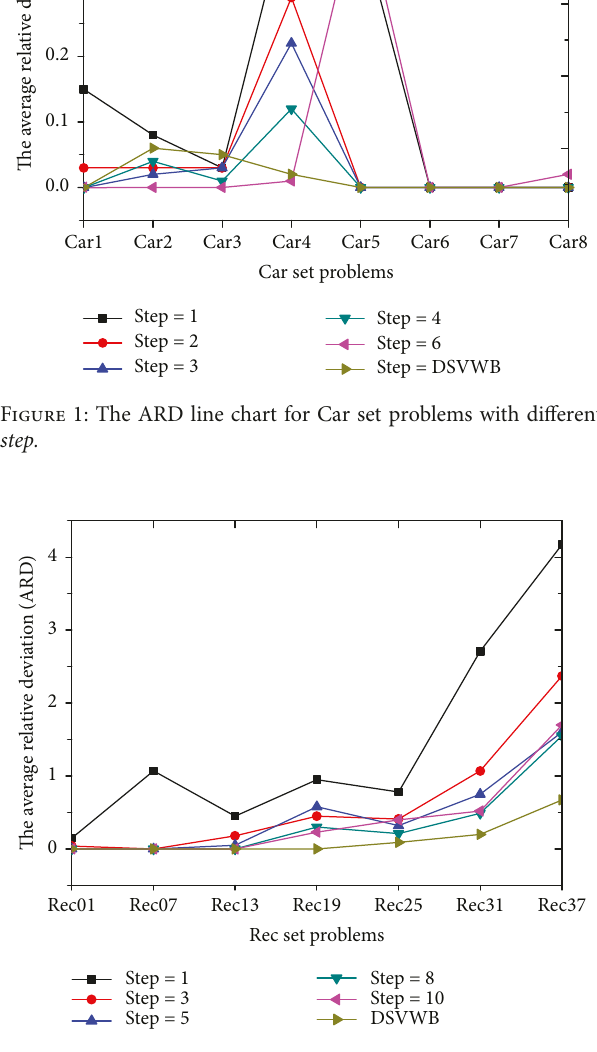
Figure 2: The ARD line chart for Rec set problems with di ff